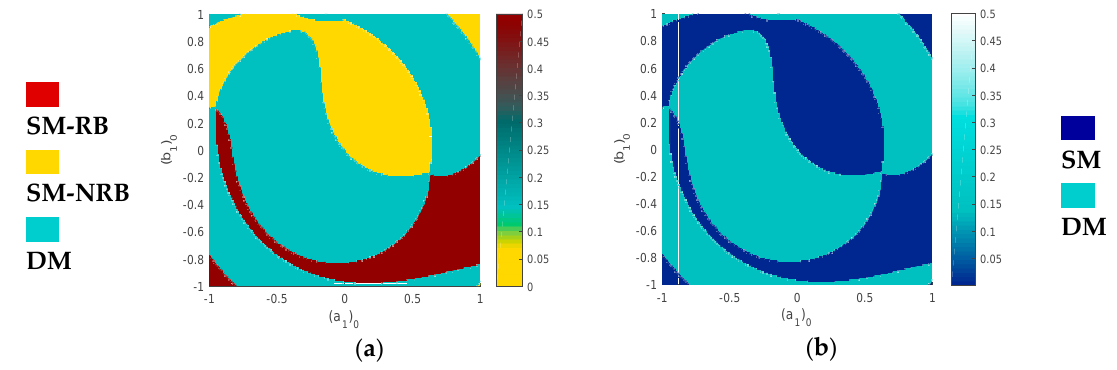
Figure 3. Basins of attraction of the deterministic amplitudes ( a ) | A 1 | 2 and ( b ) | A 2 | 2 in the Nyquist plane (((cid:1853) (cid:2869) ) (cid:2868) ,((cid:1854) (cid:2869) ) (cid:2868) ) for (cid:2026) = −1 and ((cid:1853) (cid:2870) ) (cid:2868) = ((cid:1854) (cid:2870) ) (cid:2868) = 0.25 .